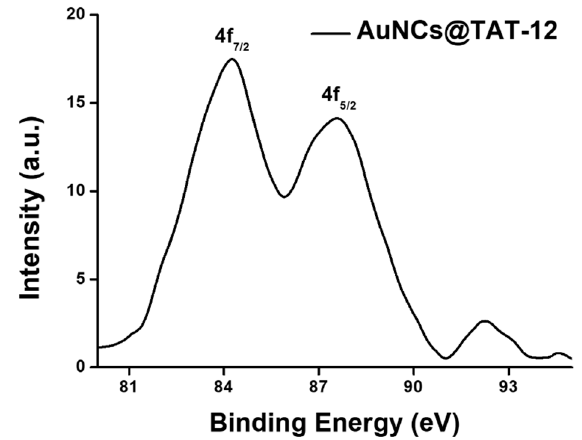
Figure 4. XPS spectra of AuNCs@TAT-12 Cys-AuNCs. The peaks of Au 4f 5 / 2 and Au 4f 7 / 2 were located at 87.6 and 84.2 eV, respectively.